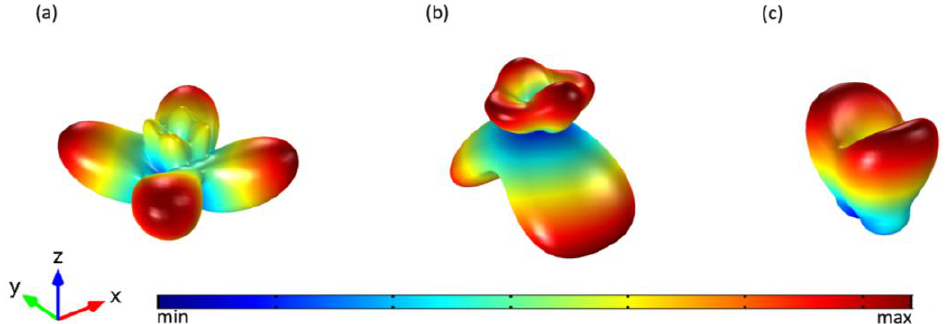
Figure 3. SH Far Field in the case of AlGaAs cylinder ( r = 232 nm, h = 400 nm) placed over ( a ) the ENZ, ( b ) the dielectric and ( c ) the gold substrate when excited by a plane wave.